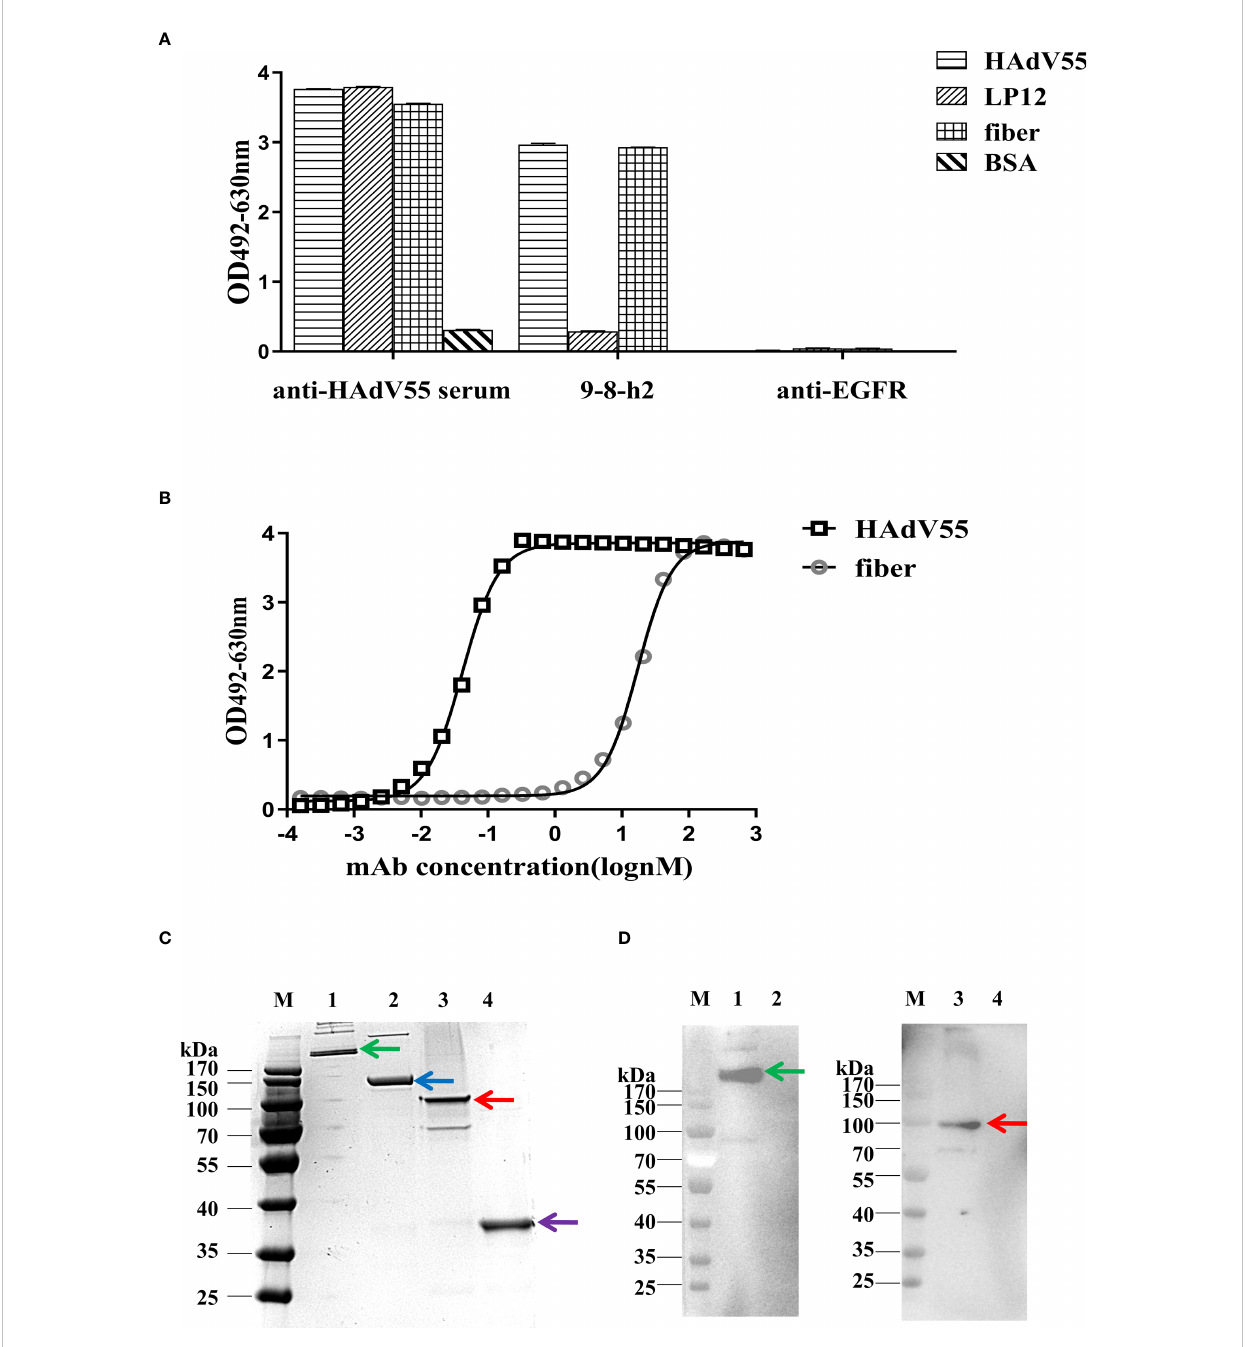
FIGURE 5 Binding of humanized mAb 9-8-h2 to the fi ber of HAdV55. (A) Binding of various antigens by mAb, assessed using ELISA analysis (n =3 independent experiments). Data are shown as the means ± SD. (B) ELISA-derived af fi nity curve for binding between serially diluted (starting concentration of 66.7 nM) humanized mAb 9-8-h2 and the fi ber (200 ng/well). (C) SDS-PAGE analysis of the puri fi ed HAdV55 and recombinant HAdV55 fi ber. Puri fi ed HAdV55 virions and recombinant fi ber proteins were heated at 98°C ( “ Reducing ” ) or stored at room temperature ( “ Non-reducing ” ) for 5min with loading buffer. (D) The polymeric form of the HAdV55 fi ber is recognized by the mAbs, as assessed using western blotting. A 300 ng/well sample of puri fi ed HAdV55 virions and recombinant fi ber protein were loaded/used in SDS-PAGE and WB analysis. Primary antibody (6667 nM) was